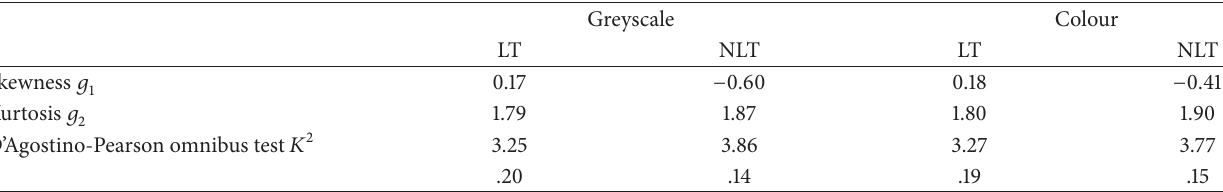
Table 3: Distribution statistics for normal controls for greyscale and colour items and the two domains: living things (LT) and nonliving things